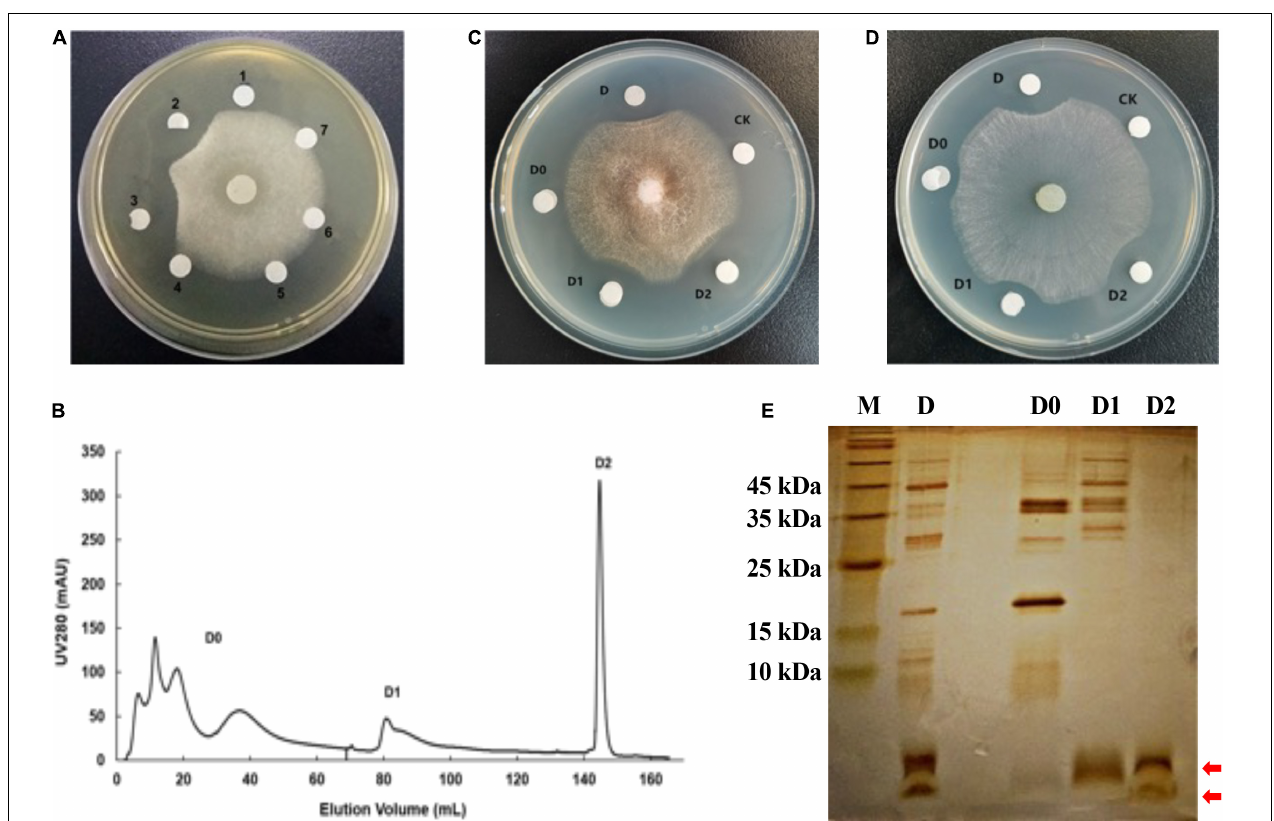
FIGURE 3 | Purification of antifungal protein by DEAE Sepharose Fast Flow column. (A) The antifungal activity of crude proteins salted out at six concentrations of ammonium sulfate against F. oxysporum . The numbers 1–7 represent the crude proteins salted out at 0, 20, 40, 60, 80, and 100% of ammonium sulfate, respectively. The number 7 represents the fermentation supernatant without protein. (B) Chromatographic profile of crude proteins of the strain W0101 extract on HiTrap DEAE Sepharose Fast Flow column using AKTA pure 25 system. (C) The antifungal activity of several fractions from crude protein against F. oxysporum. (D) The antifungal activity of several fractions from crude protein against S. sclerotiorum . (E) 15% SDS-PAGE profile of several fractions in the separation of crude proteins. The red arrows show the two distinct protein bands of fraction